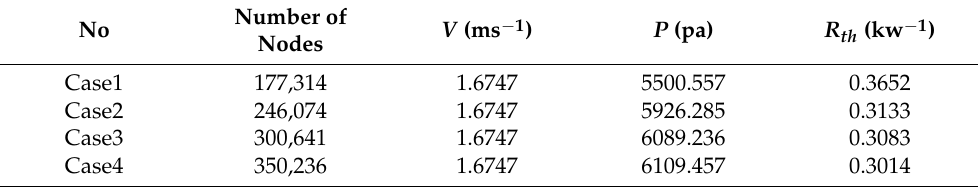
Figure 3. Computational meshes for different cross-section microchannels. Table 6. Grid independency of hydrothermal results for a rectangular microchannel heat sink.